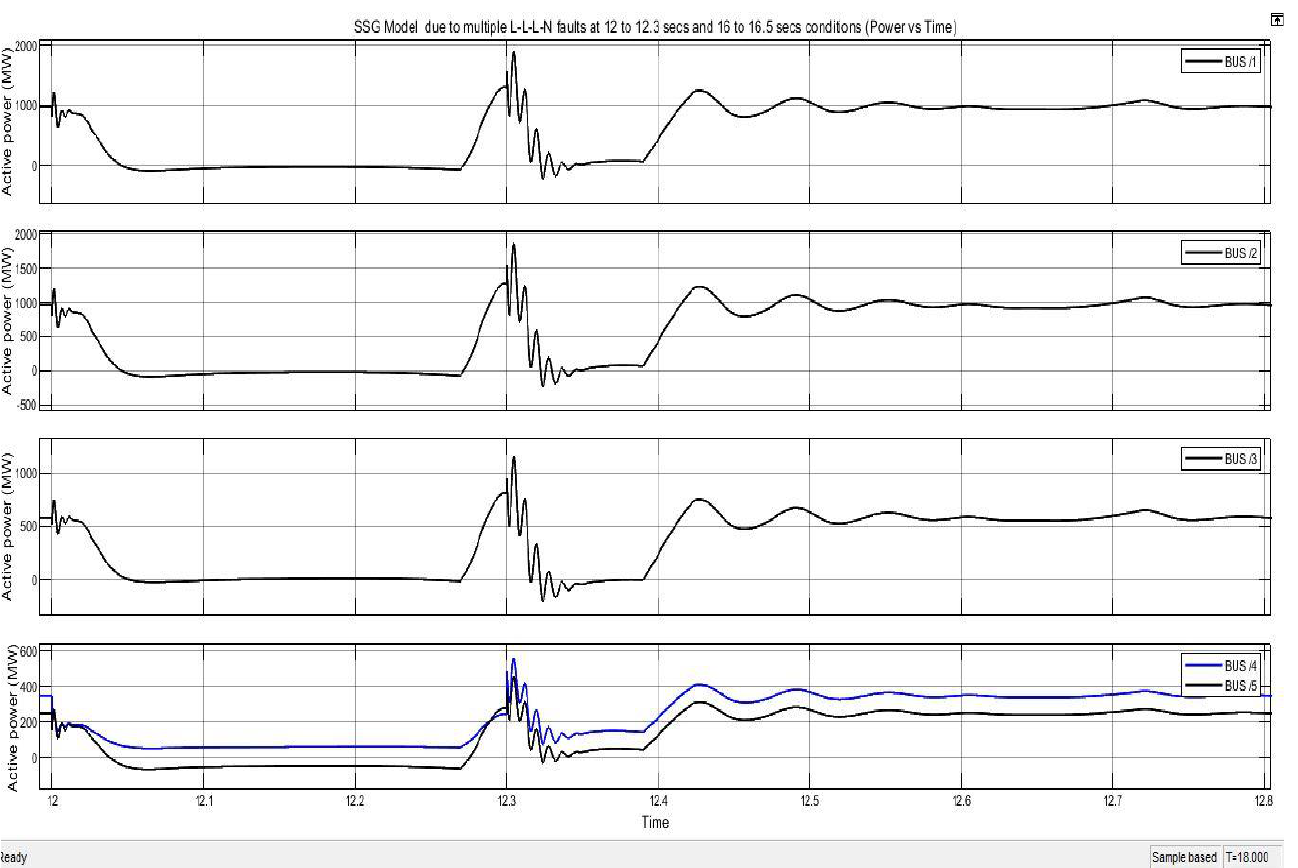
Figure 31. Multiple line-to-line (L-L-L-N) faults are inserted in the system from 12 to 12.3 s (Bus 1 to Bus 5). Bus